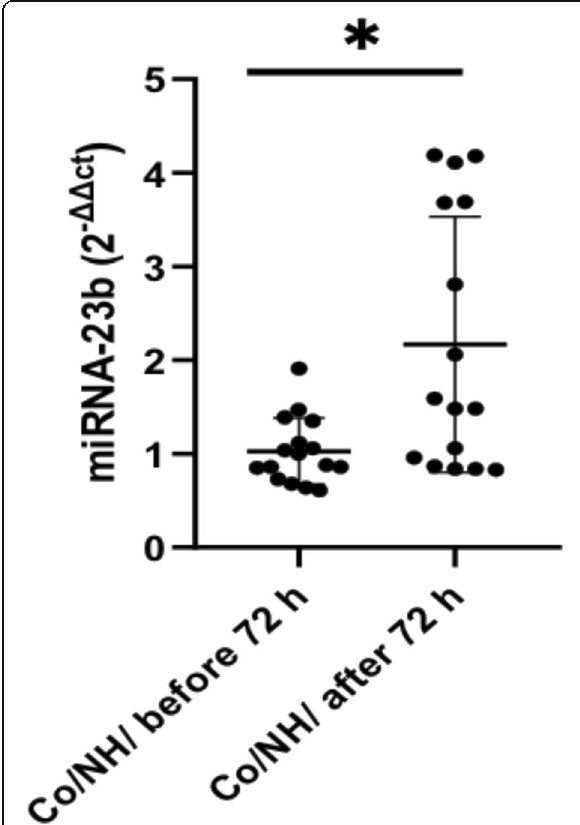
Fig. 3 Change in the miRNA-23b expression levels in newborns at two different stages. Scatter plot values represent the miR-23b level for the negative control of EOS ( n = 9) and the negative control of LOS ( n = 6) in terms of the newborns, measured by (2 - ΔΔ CT ). The line inside the boxes corresponds to the median values. LOS/ Bac-: negative haemoculture in LOS, Co/NH before 72 h: negative haemoculture in EOS, where patients ’ age was less than 72 h, Co/NH / before 72 h: negative haemoculture in LOS, where patients ’ age was more than 72 h. * p = 0.011 via the Mann-Whitney U